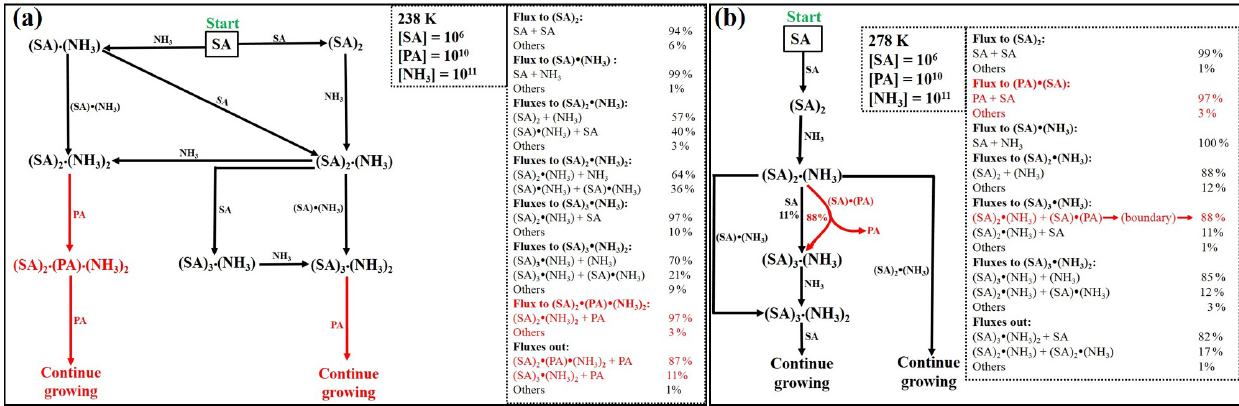
Figure 6. Main cluster pathways at (a) 238 and (b) 278K. Monomer concentrations are [ SA ]= 10 6 molec . cm − 3 , [ PA ]= 10 10 molec . cm − 3 and [ NH 3 ]= 10 11 molec . cm − 3 . Red color indicates the path involving